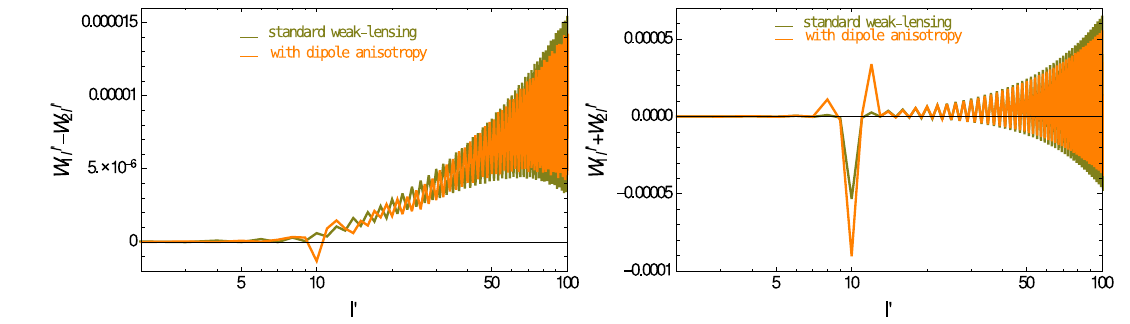
with respect to l (cid:3) for l = 10 1 l